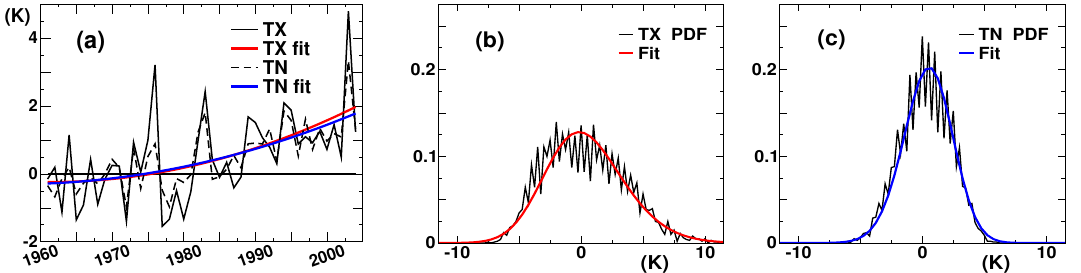
Figure 2. (a) Time evolution of mean summer anomalies for TX (black solid line) and TN (black dashed line) over the AT region, together with their second order polynomial fits (red and blue lines respectively). (b–c) Empirical versus model PDFs for detrended summer (b) TX anomalies altogether, and similar for (c) TN. Model parameters are given in Sect. 4.